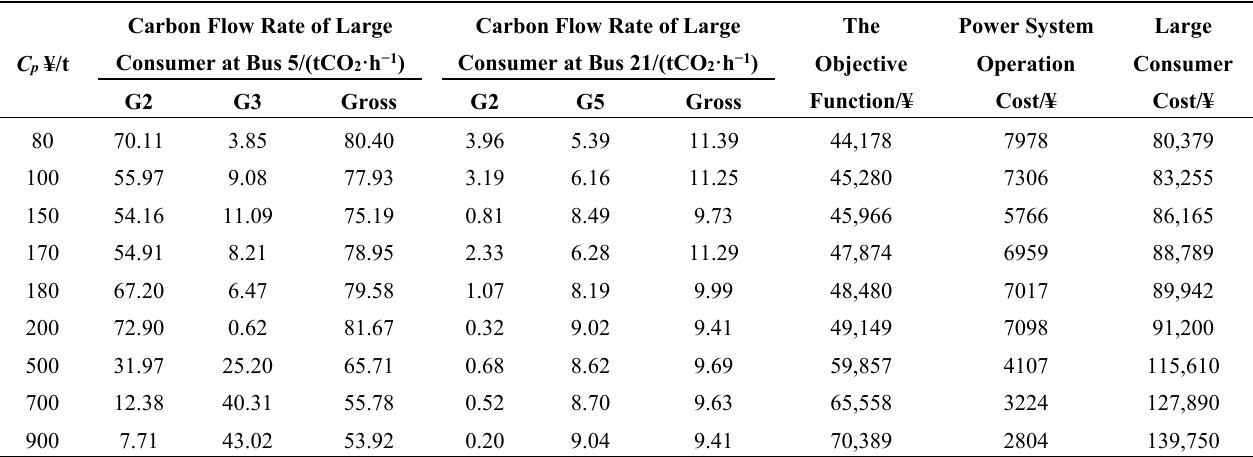
Table 8. Results under the conditions of different carbon emission prices.